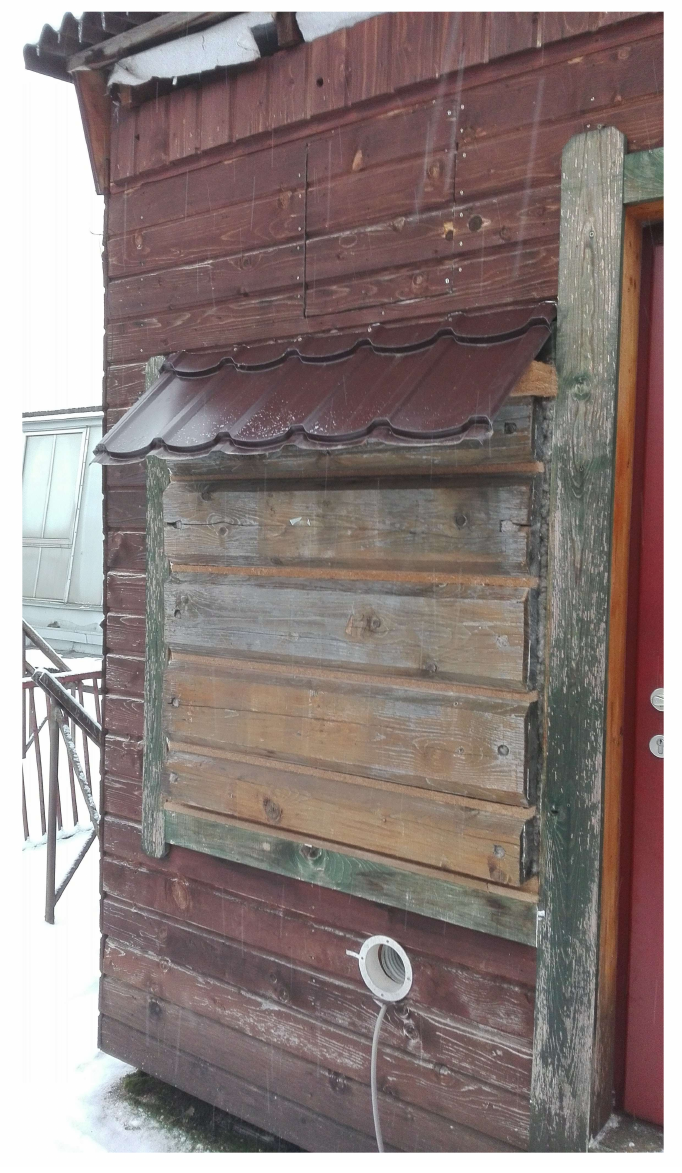
Figure 3. Log Wall LW1 and LW2 Installed in the Research Timber Structure,